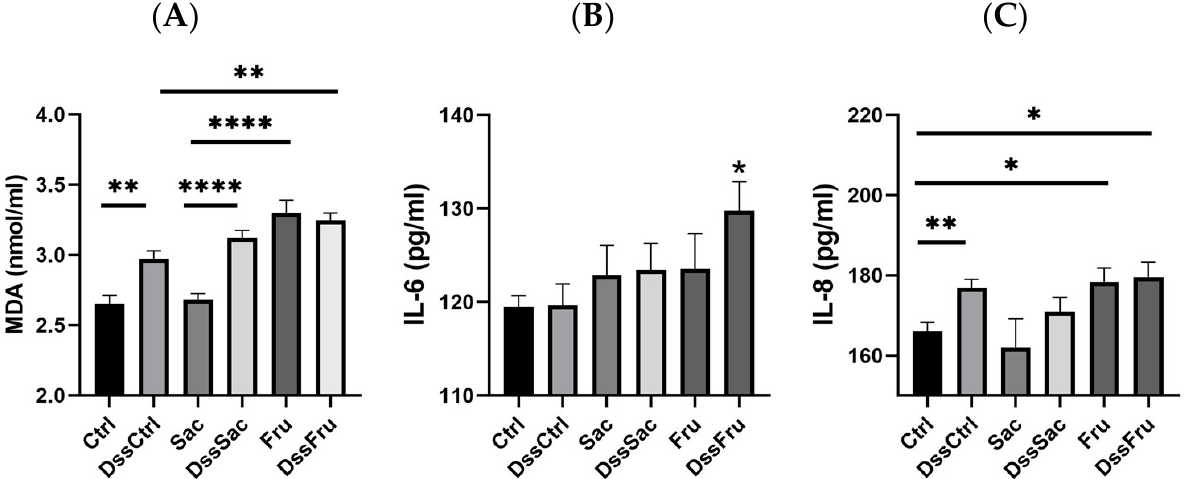
Figure 2. Fructose induced more oxidative stress and inflammatory levels in serum: ( A ) malondi- aldehyde (MDA) level in serum; ( B ) interleukin-6 (IL-6) level in serum; ( C ) interleukin-8 (IL-8) level in serum; n = 8. Data represent the following: means ± SEM, * p < 0.05, ** p < 0.01, **** p < 0.0001.